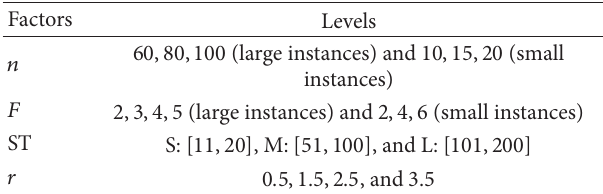
Table 2: Factors and the levels of the instances